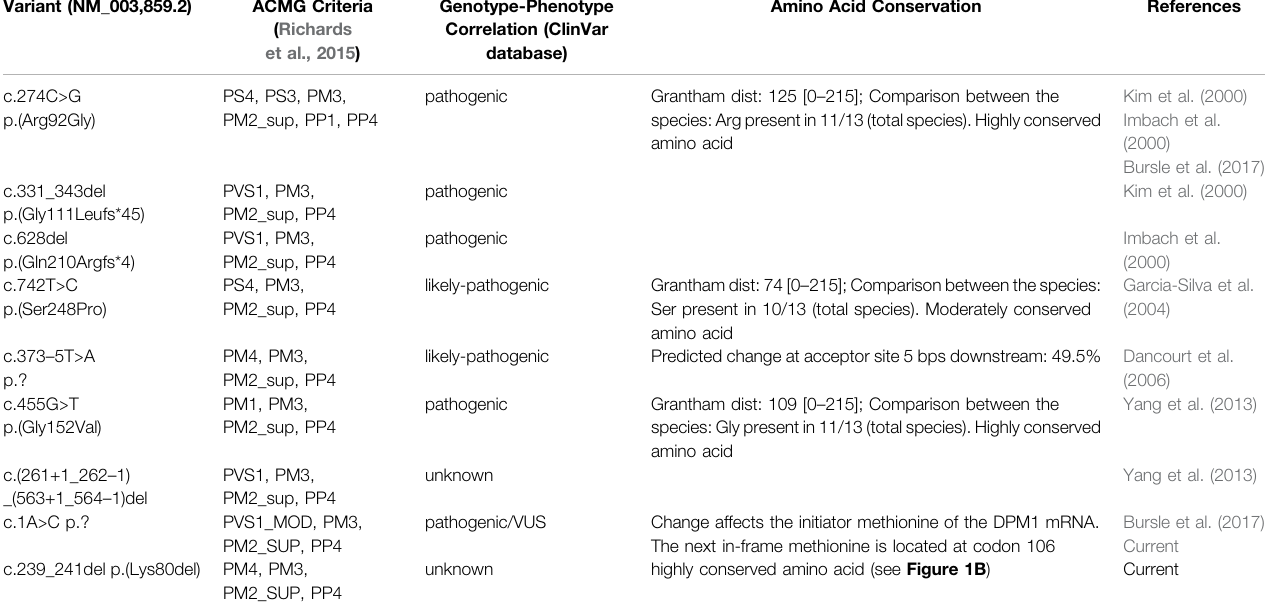
TABLE 2 | Review of reported DPM1